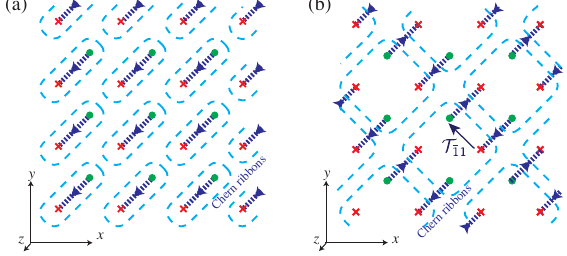
FIG. 8. Chiral Dirac channels ( and ) realized on the edge of Chern insulating ribbons (dark blue directed lines) stacked along ¯110 the ð Þ normal direction.